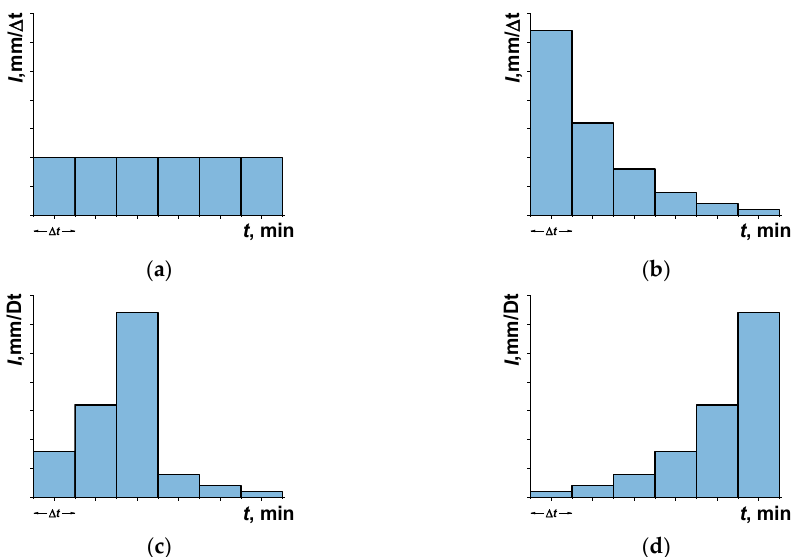
Figure 1. Typical rainfall intensity distributions over time, according to DVWK [16]: ( a ) constant intensity precipitation (i.e., block precipitation), ( b ) precipitation with a maximum intensity at the beginning, ( c ) precipitation with a maximum intensity at the center, and ( d ) precipitation with maximum intensity at the